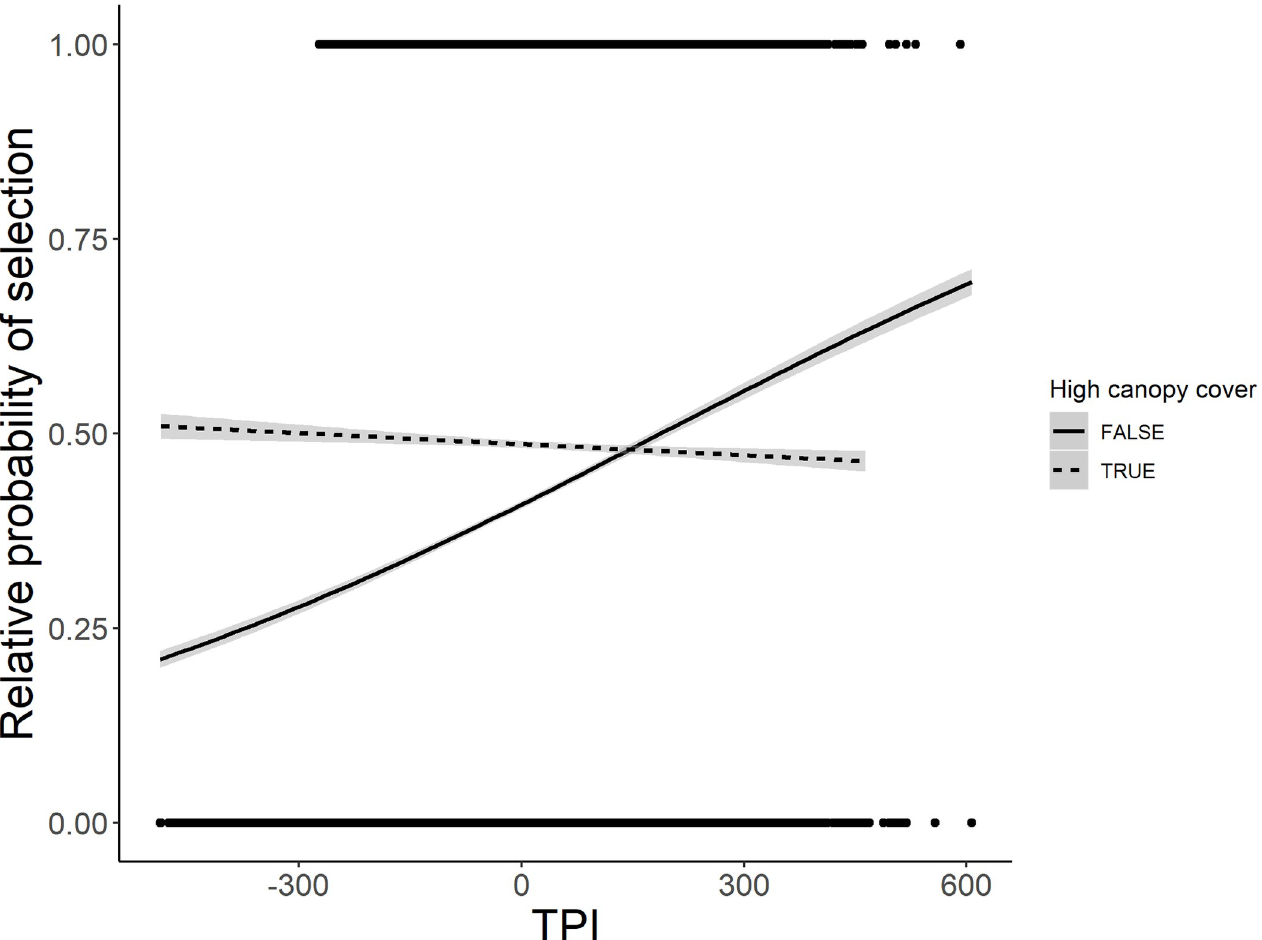
Fig 5. Selection for topographic position in high versus low canopy cover by mountain lions in the Garnet Range. Relative probability of selection for topographic position index (TPI) in high canopy cover ( > 54%, dashed line) versus low canopy cover ( < 54%, solid line) areas by mountain lions in the Garnet Range, MT, USA. This cutoff was calculated as the median value of canopy cover at available locations. A positive slope indicates selection for ridgelines and peaks, while a negative slope indicates selection for drainages.